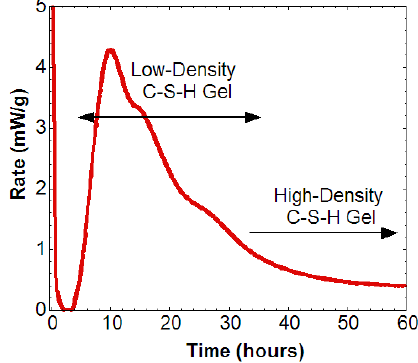
Figure 2. Density of the C-S-H gel [44]